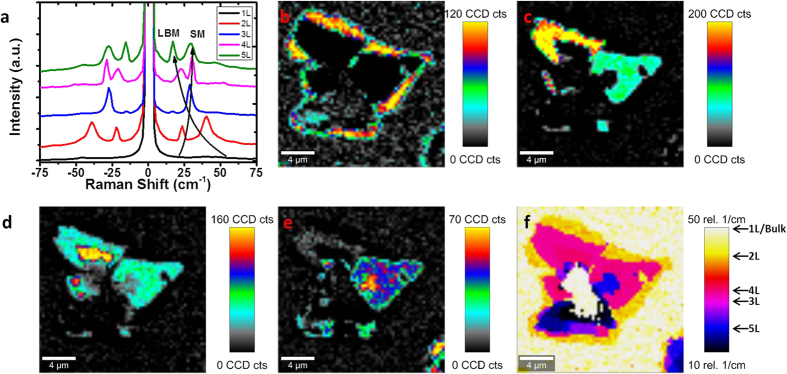
(a) Low-frequency Raman spectra of SMs and LBMs of 1, 2, 3, 4 and 5L MoS2. (b) Peak intensity map of LBM mode for 2L MoS2 at ~40 cm−1. (c) Peak intensity map of max SM/LBM for 3L MoS2 at ~29 cm−1. (d) Peak intensity map of max SM for 4L MoS2 at ~31 cm−1. (e) Peak intensity map of LBM for 5L MoS2 at ~17 cm−1. (f) Map of position of maximum peak intensity in the region of 10–50 cm−1.